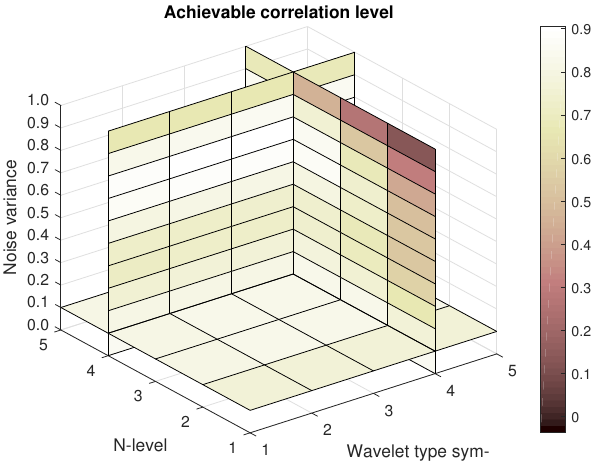
Figure 9. Construction of a 4D matrix with achievable correlation level for different combinations of Symlet mother wavelet order and decomposition level for various amounts of added artificial noise as a composite of matrices shown as examples in Figure 8.